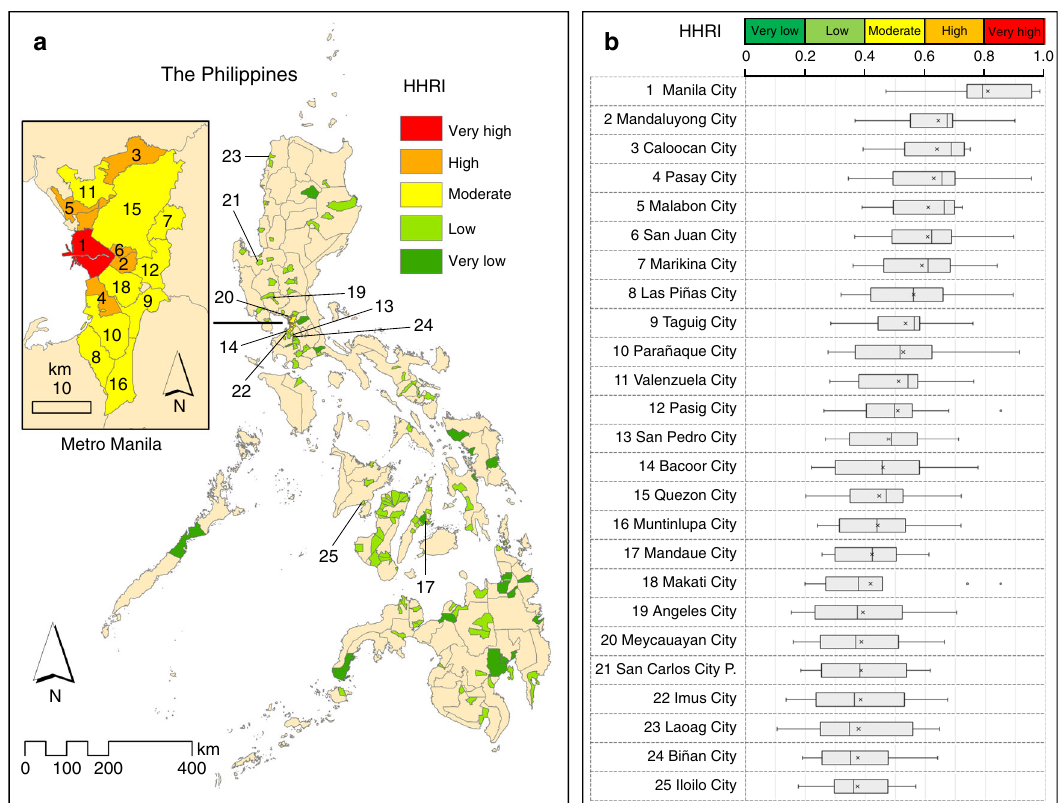
Fig. 4 Derived current overall heat health risk index (HHRI) values for Philippine cities (c. 2015). a Spatial distribution of the cities, with their corresponding current heat health risk levels. b Boxplots of the top 25 cities in terms of HHRI ( n = 12). The central rectangle of each box plot spans from the fi rst quartile Q1 (left side end of the box) to the third quartile Q3 (right side end of the box), which is the interquartile range (IQR = Q3-Q1) 90,91 . The vertical line inside each box is the median. In cases where the HHRI values are higher than the upper fence for outliers (Q3 + 1.5×IQR), the upper whisker (the end of the line that is on the right side of the box) is the highest HHRI value below the upper fence; otherwise, the upper whisker is equal to the highest HHRI value 90,91 . In cases where the HHRI values are lower than the lower fence for outliers (Q1 – 1.5×IQR), the lower whisker (the end of the line that is on the left side of the box) is the lowest HHRI value above the lower fence; otherwise, the lower whisker is equal to the lowest HHRI value 90,91 . The symbol “ x ” on the boxplots represents the average of the 12 risk assessment results, considered here as the overall HHRI of each city; these values were the ones used to produce the map ( a ). The HHRI distributions were mostly skewed, with an apparent positive skew for Manila City. The “ P. ” in “ 21 San Carlos City P. ” refers to the province of Pangasinan. Summary results for all the cities are presented in Supplementary Table 4. See Methods for